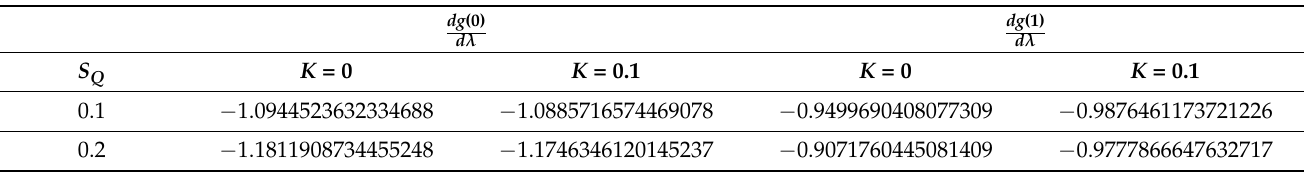
Table 5. Numerical computations of Torque at a fix circular and upper circular plates by DTM-Pad é [ 5 × 5 ] for various values of Squeezing Reynolds Number S Q .